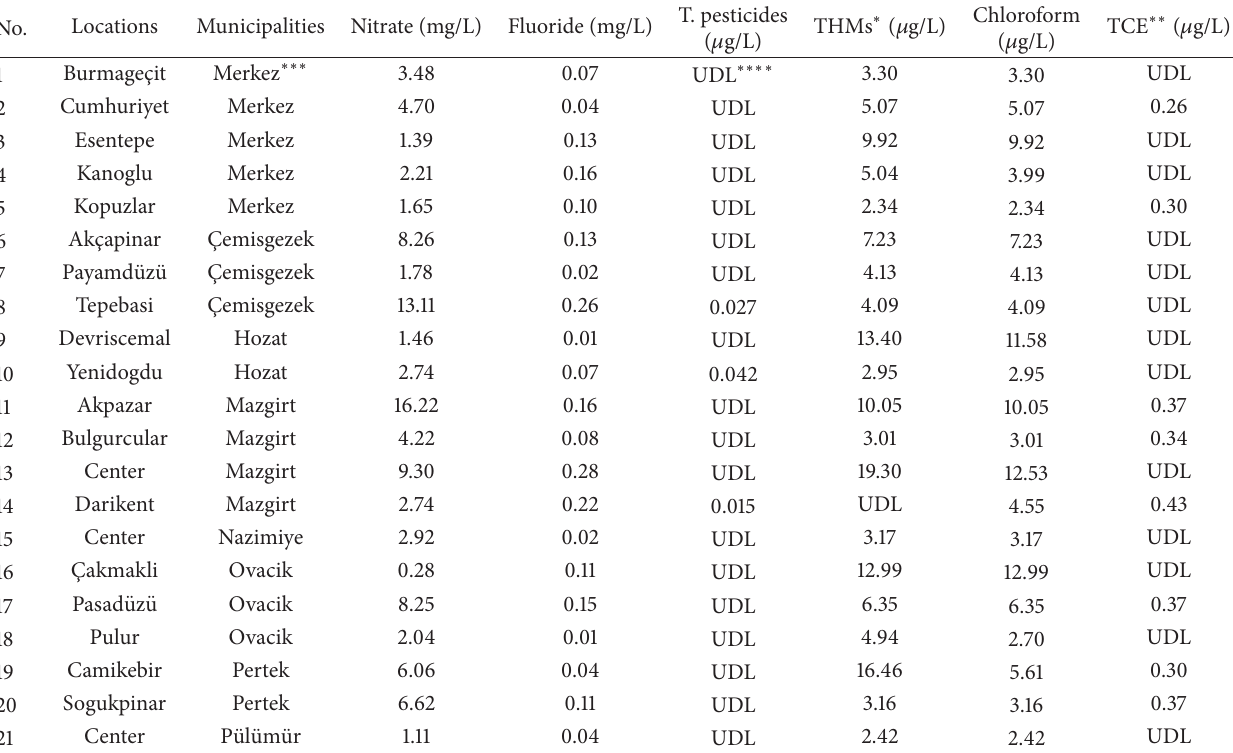
Table 1: Concentrations of the studied chemicals in the drinking water sampling locations of the city center and municipalities of Tunceli,